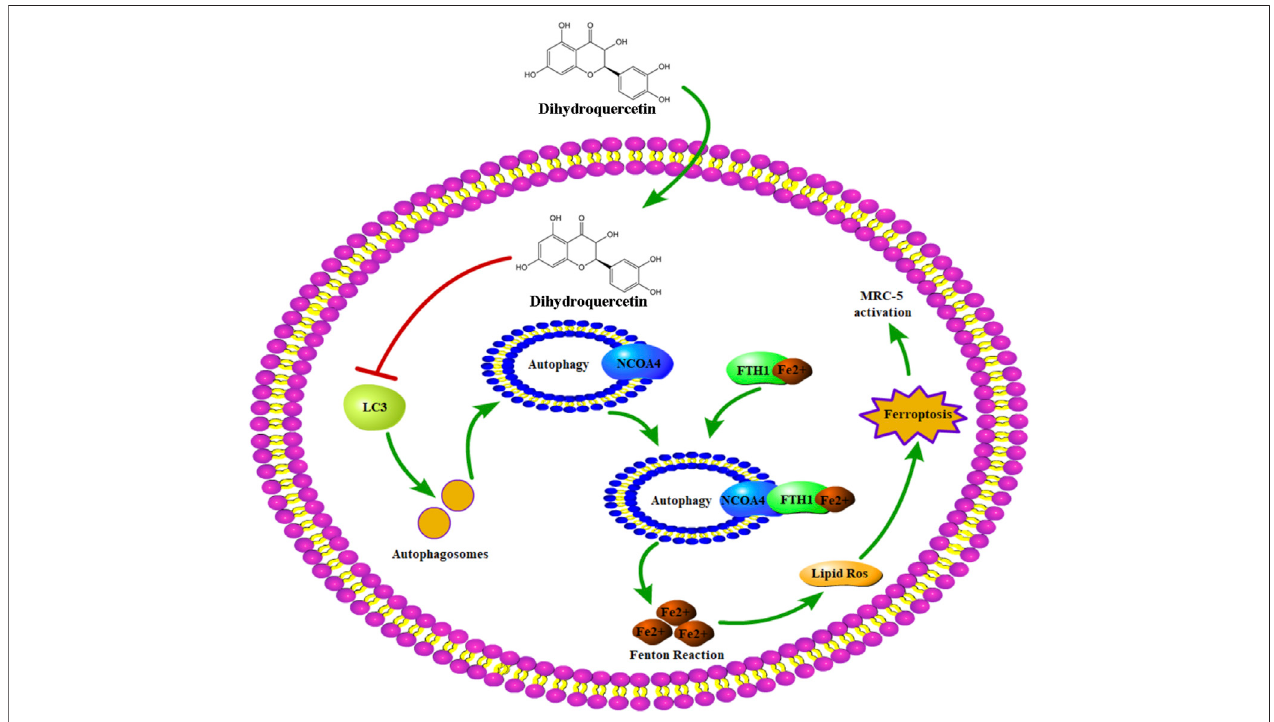
FIGURE 6 | The underlying mechanism of DHQ against silica-induced lung fi